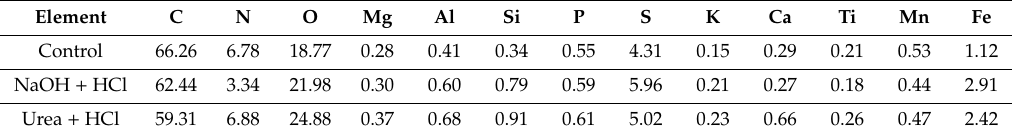
Table 3. Comparison of elemental composition (% weight) of the fouling layer as determined by energy dispersive X-ray (EDX)